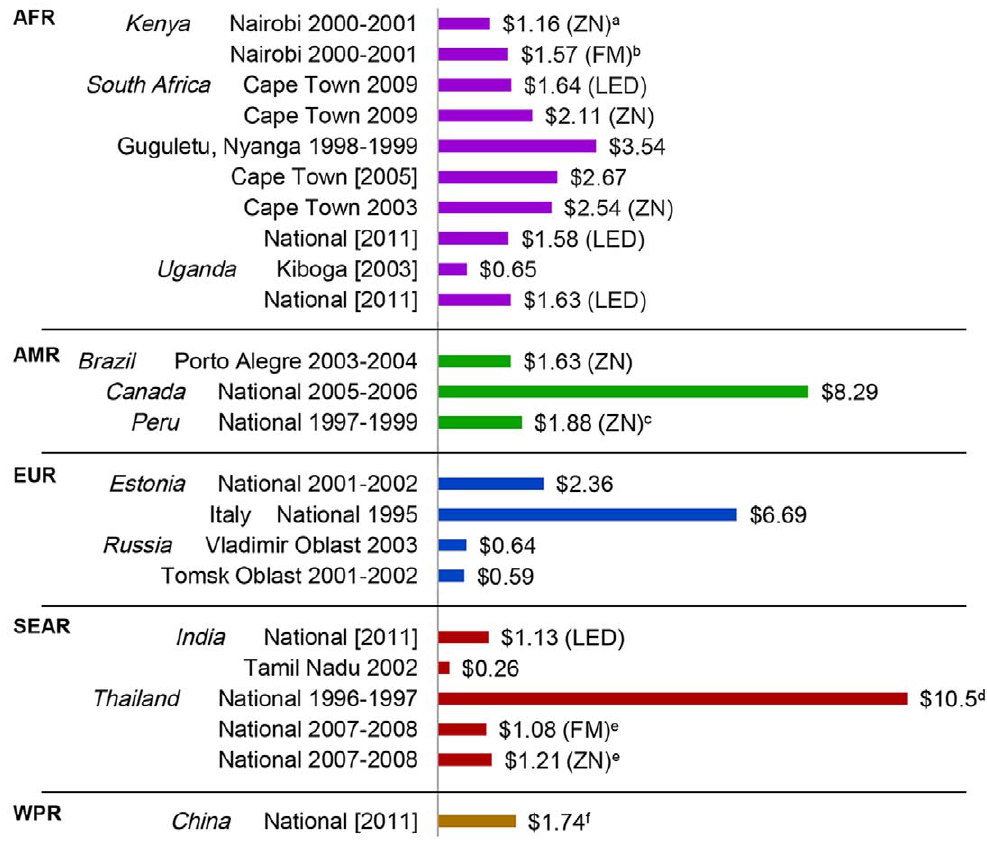
Figure 2. Unit cost in 2010 USD for smear test alone. (1) Cost data were sorted by WHO regions: African Region (AFR), Region of the Americas (AMR), Eastern Mediterranean Region (EMR), European Region (EUR), South-East Asia Region (SEAR) and Western Pacific Region (WPR). (2) For studies with available information on test methods, we labeled them at the end of each bar. (3) [] indicates publication year when data collection year is not available. (4) ZN: Ziehl-Neelsen; FM: fluorescence microscopy; LED: light-emitting diode. a $ 1.16 is the average laboratory costs on 1000 subjects and three specimens. b $ 1.57 is the average laboratory costs on 1000 subjects and three specimens. c $ 1.88 is the total cost $ 26.27 divided by 14 sputum smears. d Sum of the overhead cost ( $ 10.4) and the material cost ( $ 0.1). e For the examination of three sputum specimens, the cost per patient evaluated is $ 3.24 for FM and $ 3.59 for ZN. f The unit cost is the average over six regional estimates. For detailed information of the six regional estimates, see Table